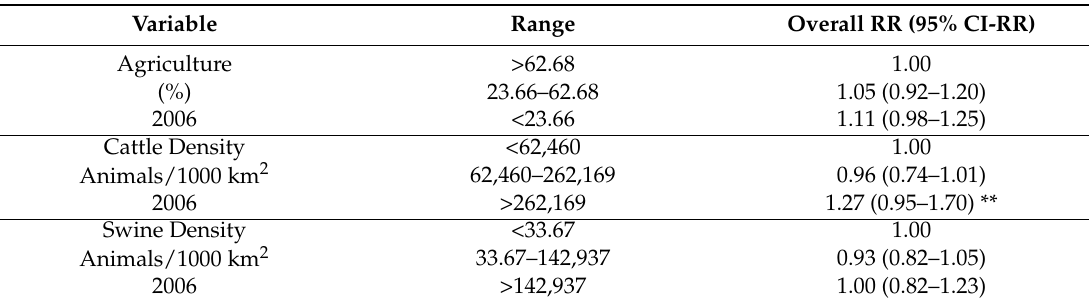
Table 2. Univariant Analysis Assessing the Impact of Cyanobacterial Surrogate Markers on Liver Cancer Development within Canada.